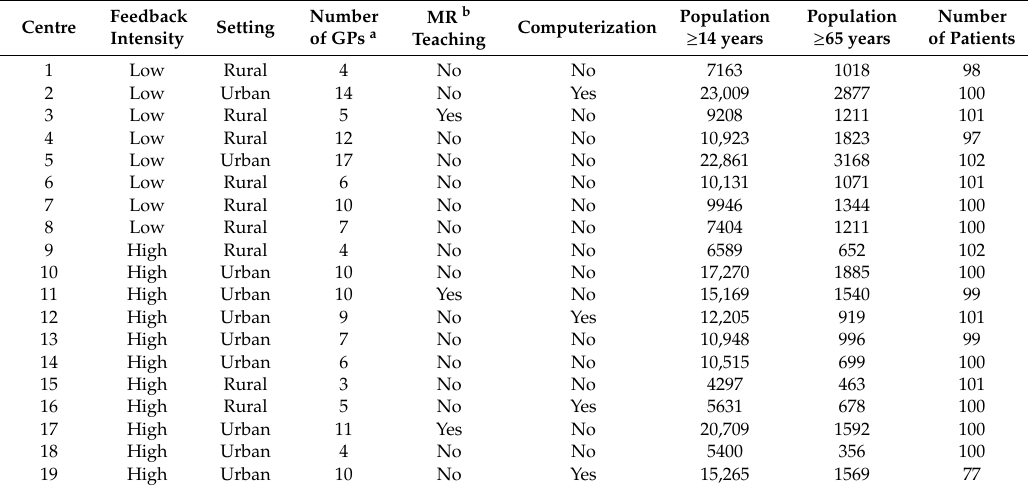
Table 1. General description of the characteristics of the 19 healthcare centres participating in the study and the number of patients analysed in each